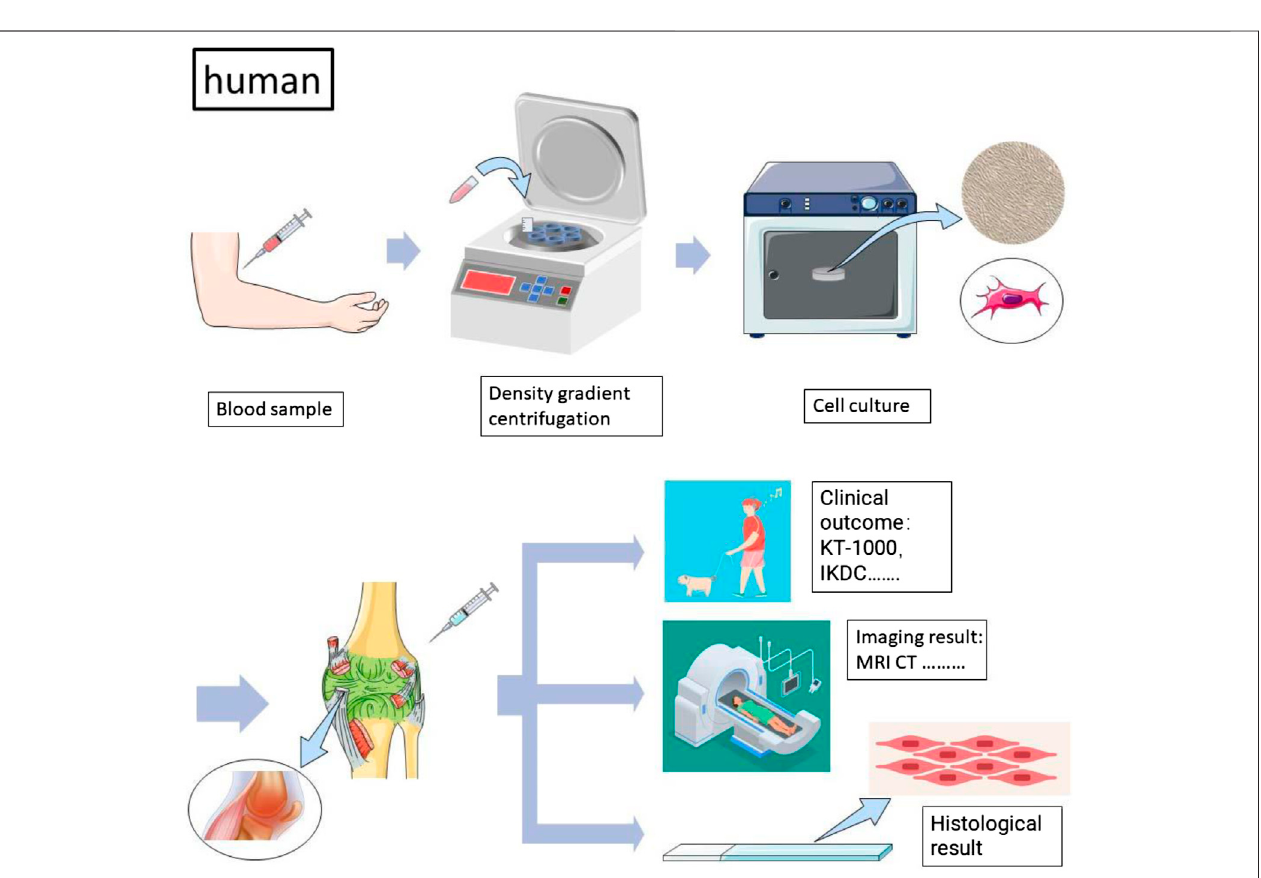
FIGURE 2 | The general process of human peripheral blood-derived stem cell experiments (in vivo).